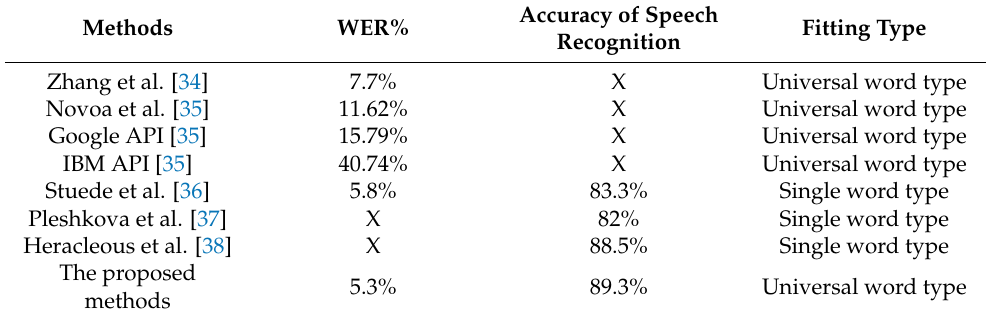
Table 5. Comparisons for WER and accuracy of speech recognition in different